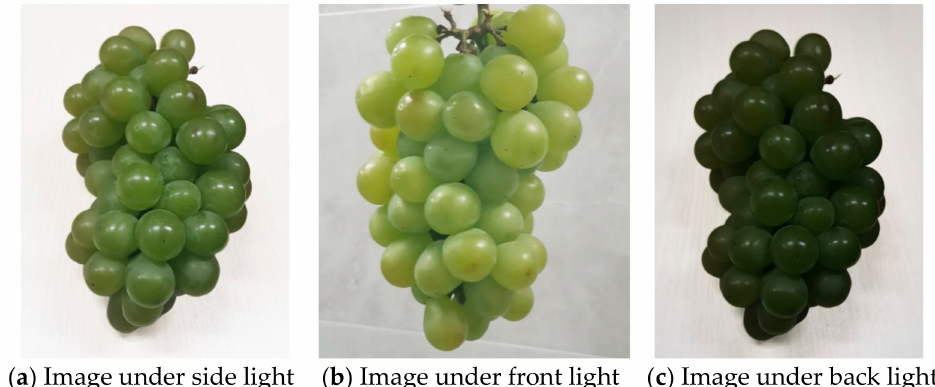
Figure 6. Images of Sunshine Muscat grapes under different lighting conditions.